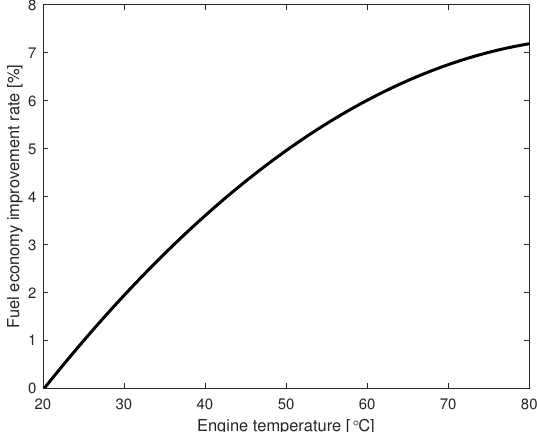
Figure 5. Effect of engine temperature on the New European Driving